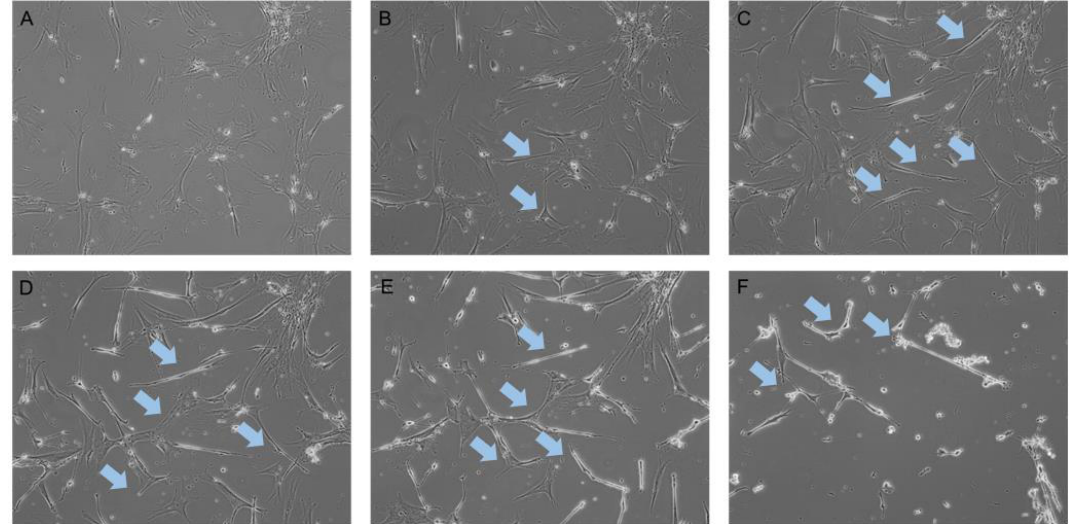
Figure 1. BME treated mesenchymal stem cells (MSCs) at 10× magnification ( A ) Basal ADSCs. Pre-induction media ADSCs ( B ) 6 h ( C ) 24 h. Induction Media ADSCs ( D ) 1 h ( E ) 6 h and ( F ) 12 h. The temporal progression of the treatment shows the ADSCs morphological change from flat dense fibroblastic cells to narrow, spindle-like cells with bipolar extension presenting early neurite outgrowth shown by blue arrows.